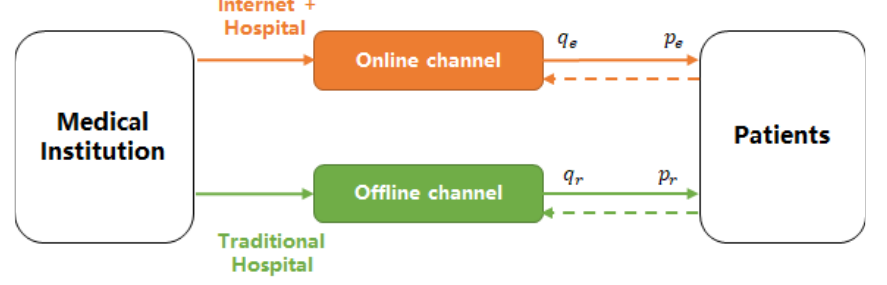
Figure 1. Dual-channel HSSC